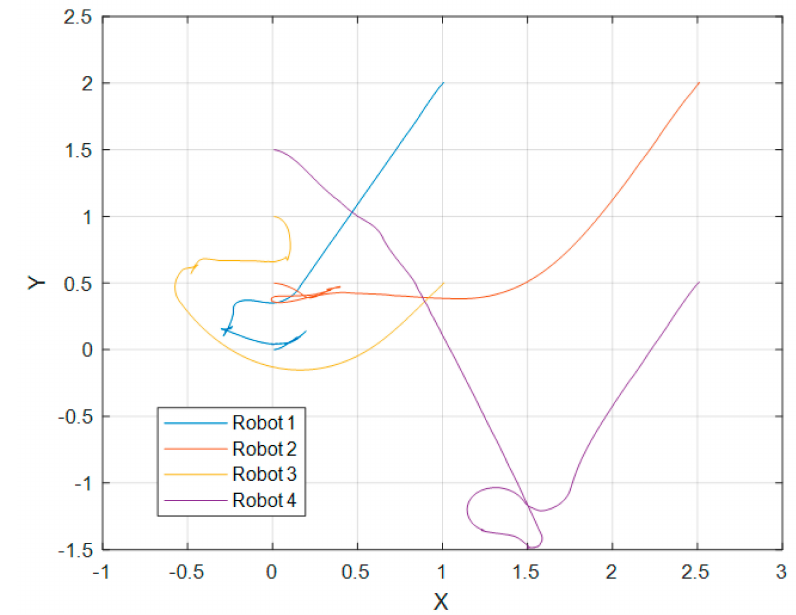
Figure 7. Trajectories in the 4-robot